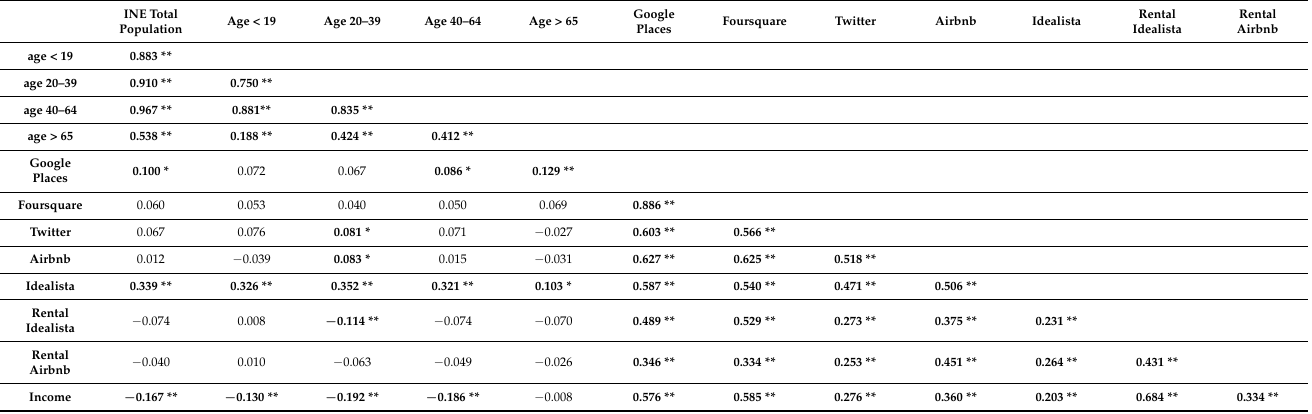
Table 2. Pearson correlation between population age, income and LBSNs